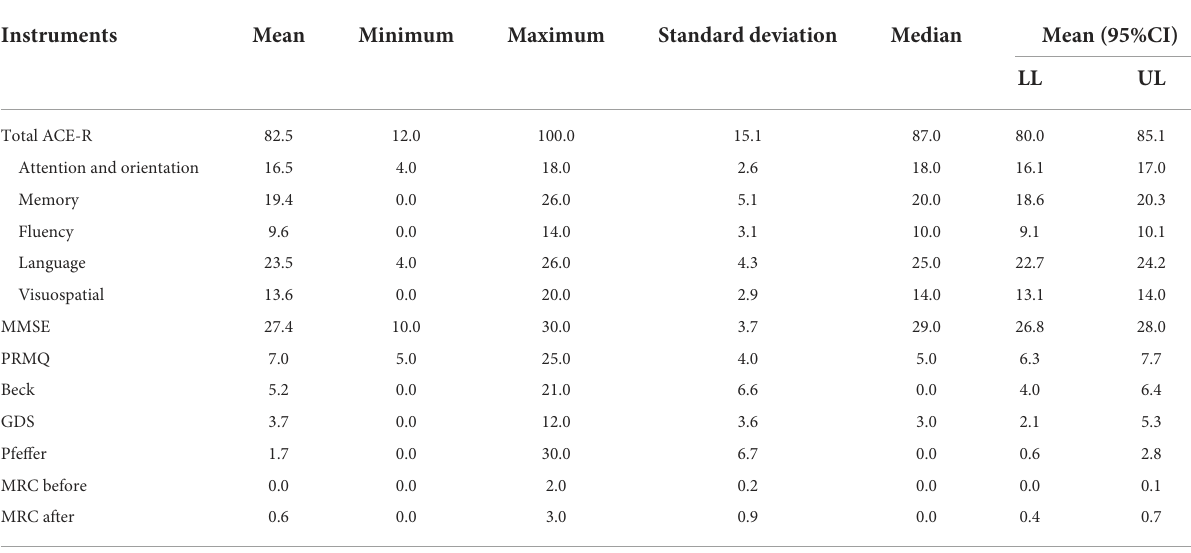
TABLE 2 Total ACER, ACER subitens, MMSE, PRMQ, Beck, GDS, Pfeffer, and MRC